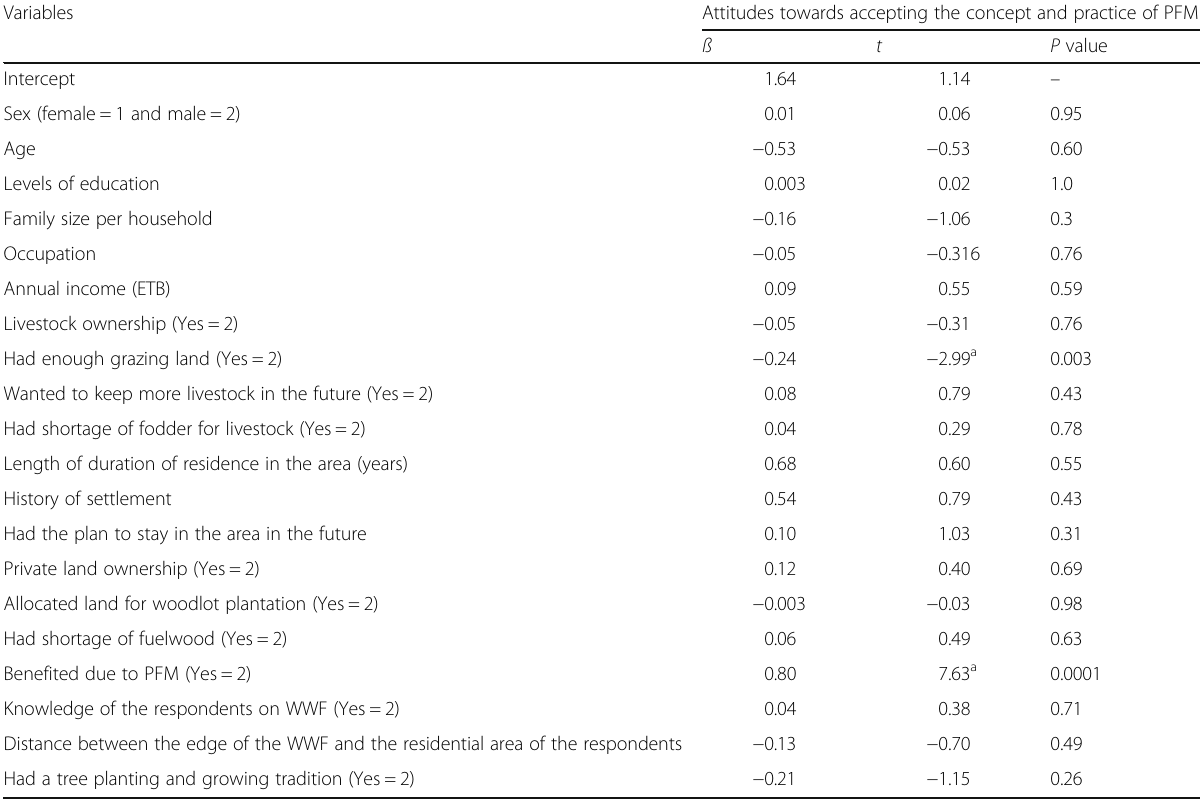
Table 6 Multiple linear regression model (standardized coefficients were reported) to predict the attitudes of local people towards accepting the concept and practice of PFM in WWF ( R 2 = 0.685 (Adj. R 2 = 0.54), df = 19; F = 4.678, overall P < 0.001) (+ = a positive change in attitudes and − = a negative change in